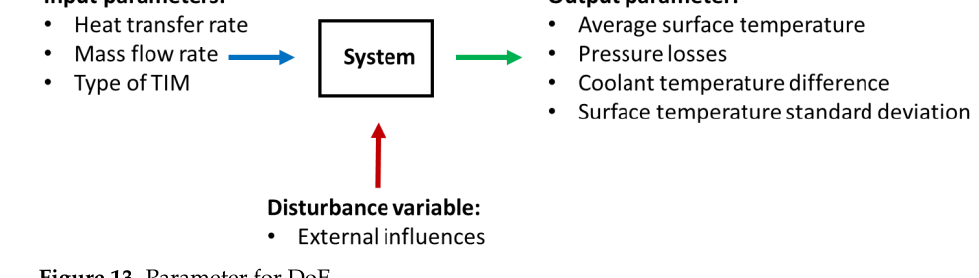
Figure 13. Parameter for DoE.